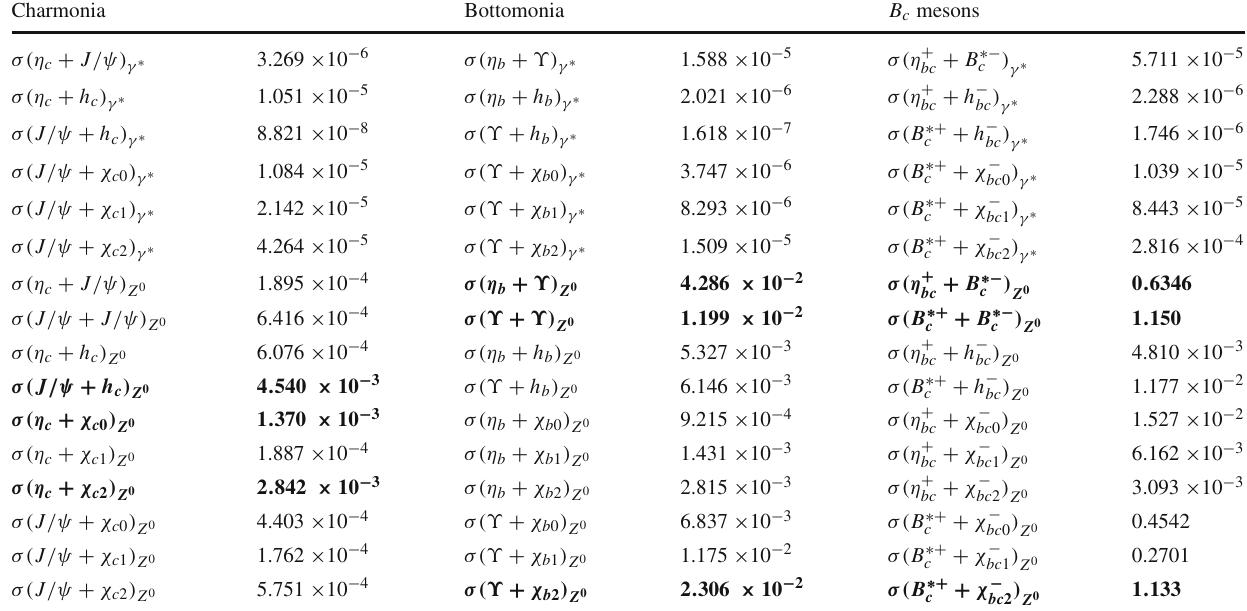
Table 2 Cross sections (units: f b ) for the production of the double heavy quarkonia and B c mesons in e + e − annihilation at within the BT-potential model [62]. The subscripts γ ∗ and Z 0 are for